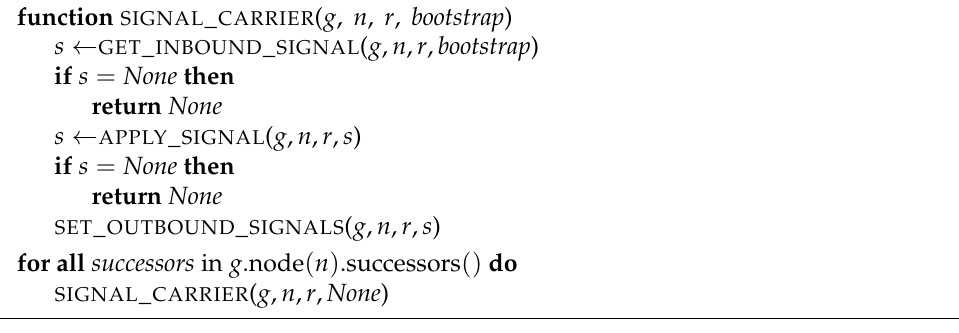
Algorithm 2 Neuronal firing signal carrier; propagate a single signal thought for all possible nodes in the neural network graph recursively based on its position.